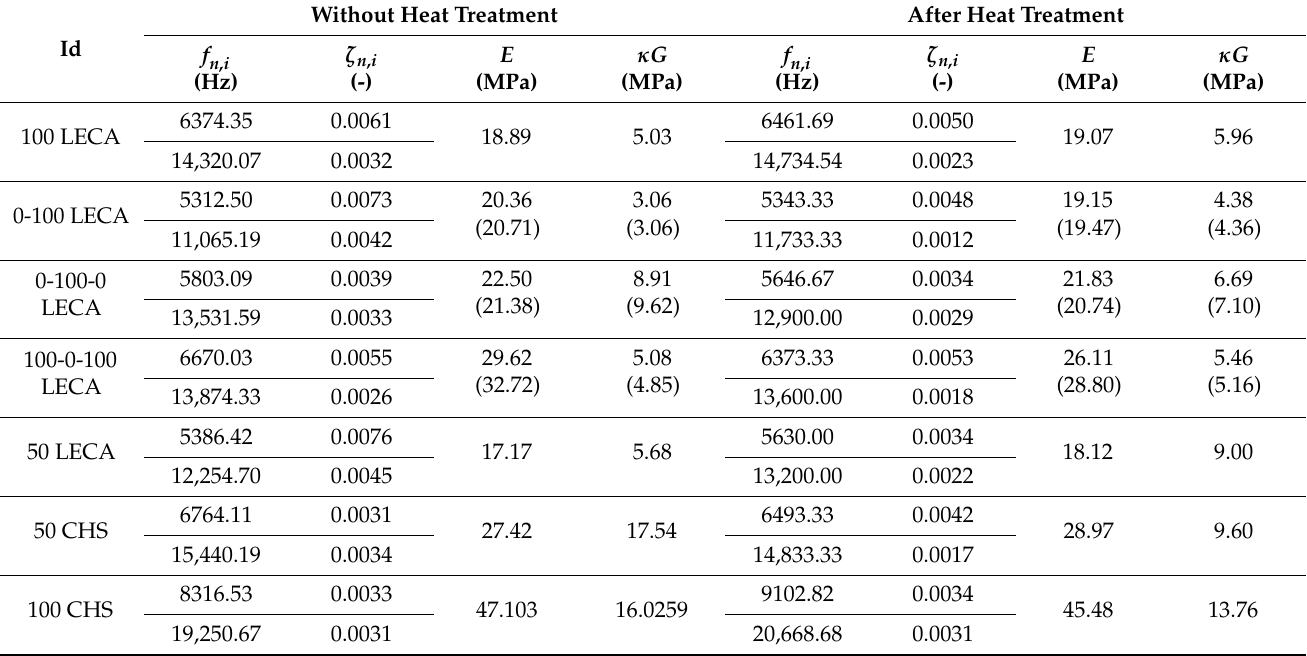
Table 4. Experimental modal analysis and material parameter fitting results. For varying density samples, values displayed in brackets denote the fitting results considering uniform